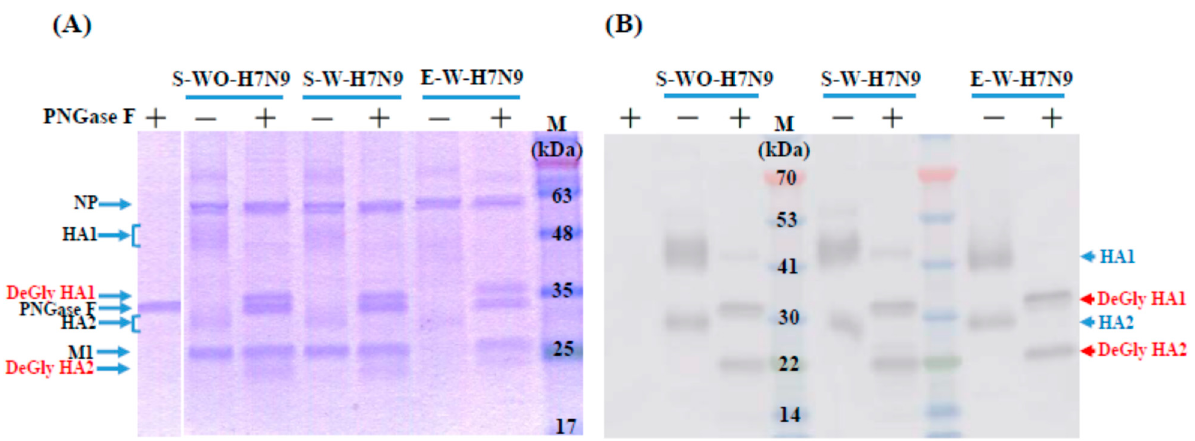
Figure 3. SDS-PAGE and Western blot analyses of three H7N9 vaccine antigens. ( A ) The first lane was only loaded with PNGase F, and then an equal number of antigens was loaded in the following lanes with or without deglycosylation using PNGase F. After electrophoresis, the gel was visualized by Colloidal Blue staining. ( B ) Antigens were detected by anti-A/Anhui/1/2013 HA serum (NIBSC code: 15/248) in the nitrocellulose membrane. NP: nucleoprotein; M1: matrix protein; HA: hemagglutinin; DeGly: deglycosylation; +: the line with PNGase F; − : the line without PNGase F.